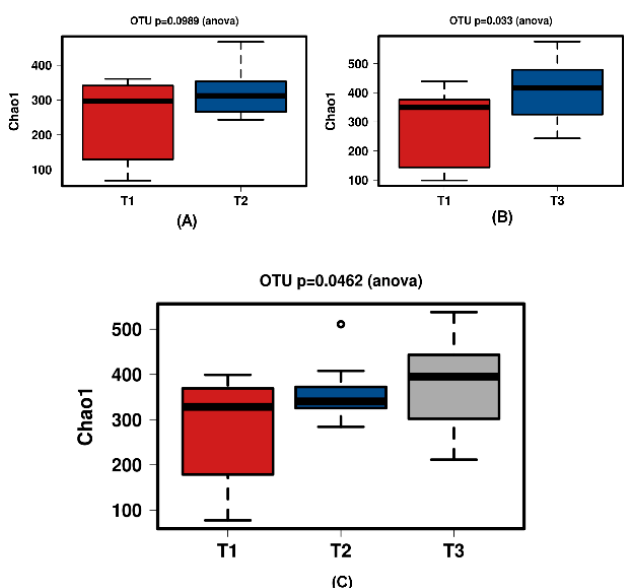
Figure 7. Diversity using Chao1 index for the synthetic group samples. ( A ) shows T1 and T2 with no significant increase over time. Samples normalised to a read depth of 564 sequences; ( B ) shows T1 and T3 with a significant increase over time. Samples normalised to a read depth of 578 sequences; ( C ) shows T1, T2 and T3 with a significant increase in diversity. Samples normalised to a read depth of 559 sequences.